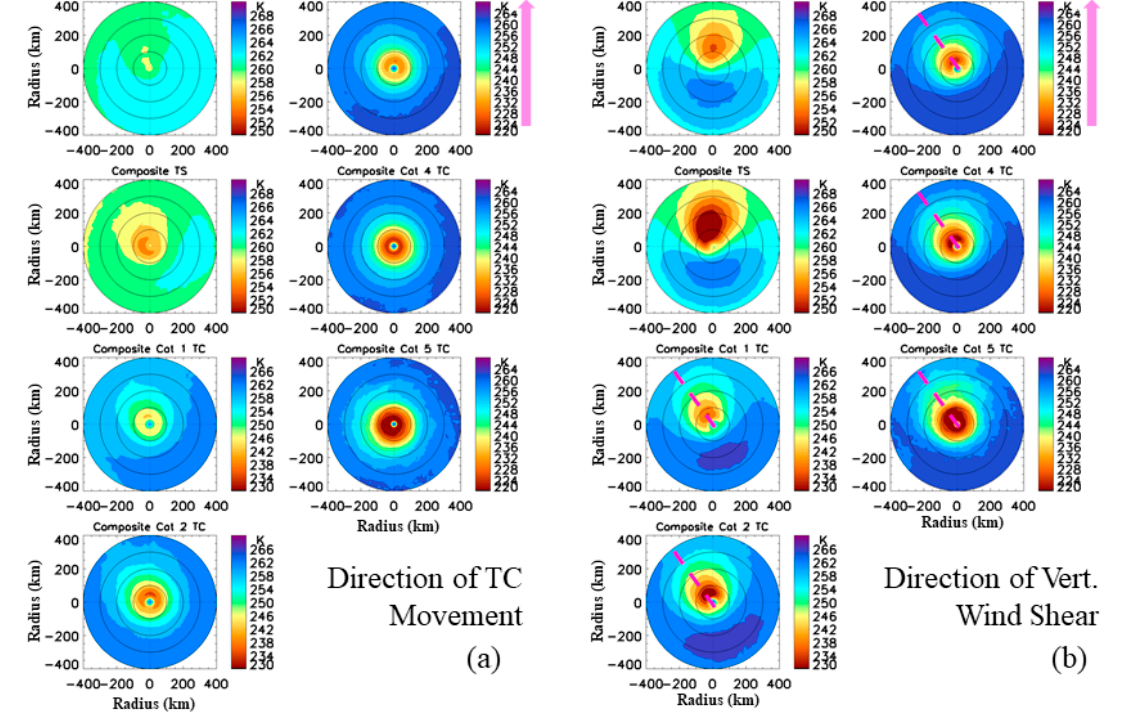
Figure 5. Same Figure 4, except for composition with regard to ( a ) direction of TC movement and ( b ) direction of the 200–850 hPa wind shear. The pink vertical arrow shows direction of the TC movement or 200–850 hPa wind shear. The red dashed line in ( b ) is for axis of the minimum TBs.